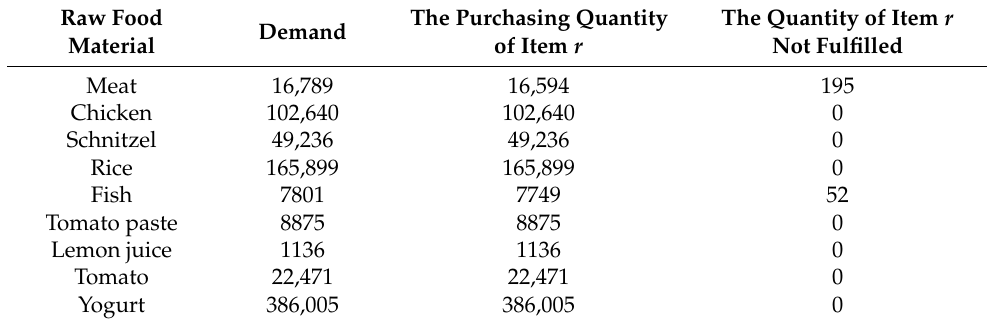
Table 9. Order quantity and fulfilled order of each item.